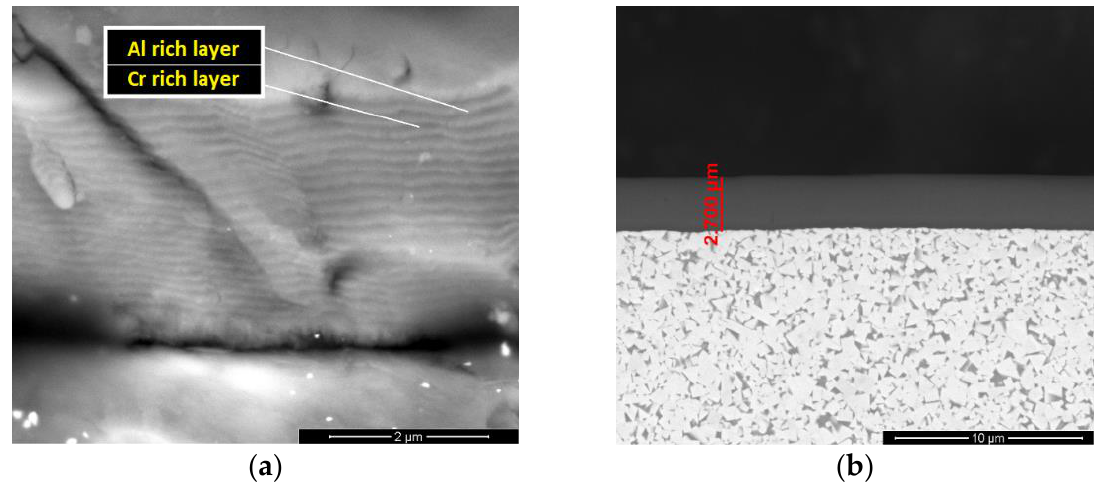
Figure 2. Coatings’ thickness analysis: multi-layered structure of the AlCrN coating ( a ); measurement of TiAlSiN ( b ).